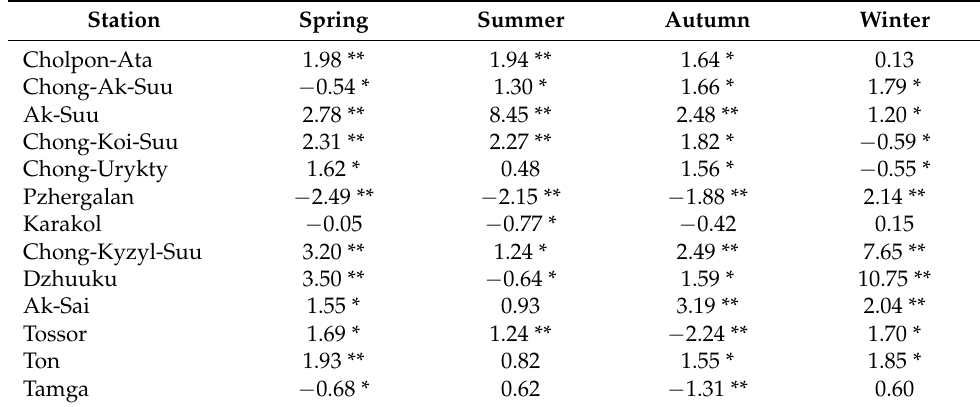
Table 4. Analysis of ITA (slope s) of seasonal river runoff (1943–2012). Station Spring Summer Autumn Winter